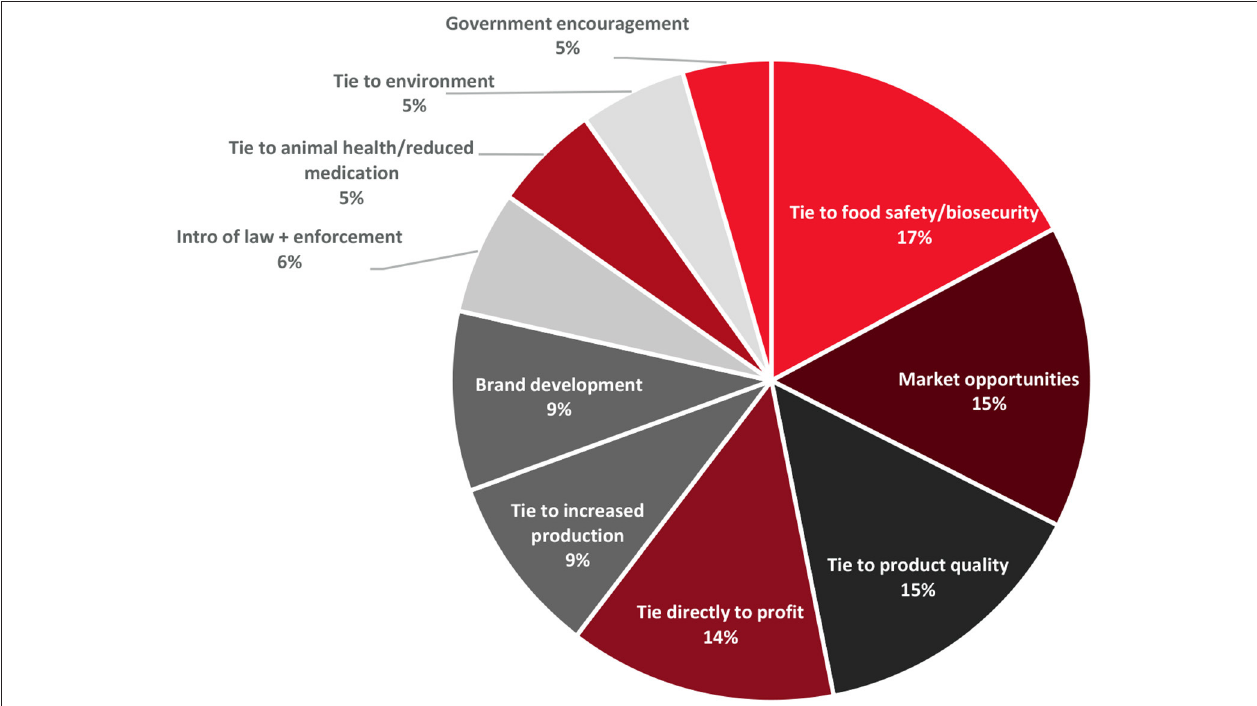
FIGURE 1 | Pie chart comparatively displaying the 10 most frequently identified elements to attract attention to animal welfare within